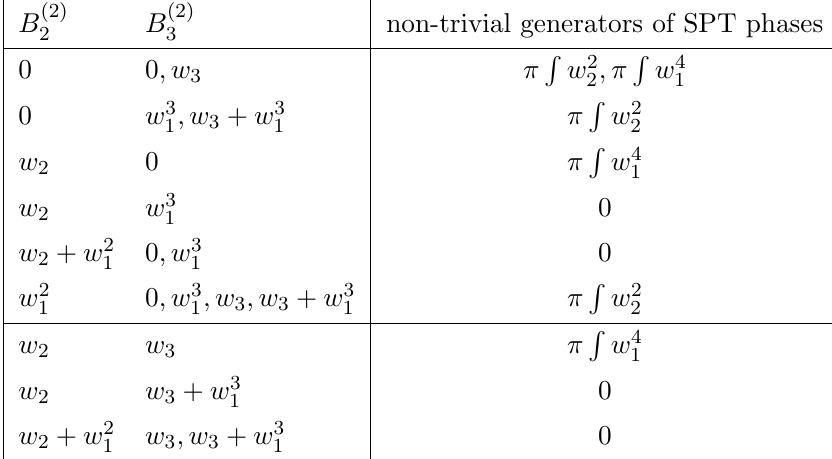
Table 3 . The di(cid:11)erent couplings of Z 2 gauge theory to the time-reversing Lorentz symmetry, and the non-trivial SPT phases that the couplings admit. The couplings are represented by di(cid:11)erent backgrounds B (2) ; B (2) . The SPT phases for time-reversal symmetry can be generated by (cid:25) R w 2 2 3 (cid:25) R w 4 , but some of them can be trivialized by the coupling, and we list the non-trivial generators 1 for each coupling. The entries above the line in the middle are non-anomalous, while those below the line have the gravitational anomaly (cid:25) R w 2 w 3 . In total there are 25 non-anomalous symmetry- enriched